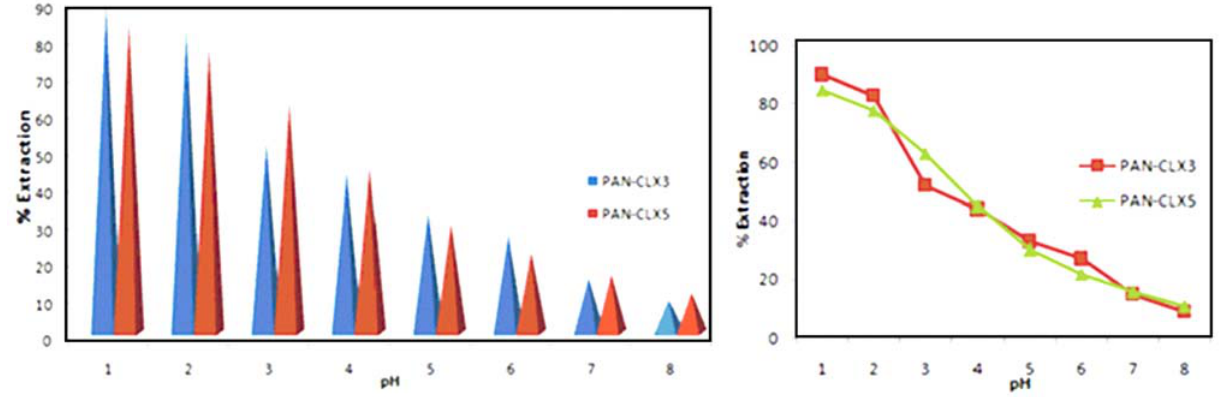
Figure 6. Extraction percentages (%E) versus pH following the solid phase extraction of dichromate anions with nanofibers PAN-CLX3 and PAN-